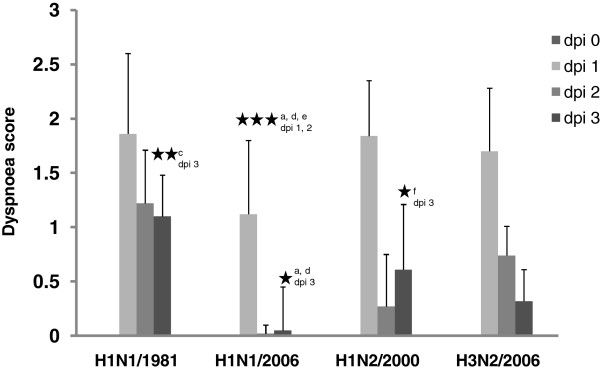
Dispnoea score. Dyspnoea (score) observed in pigs after experimental infection with influenza A viruses, dpi, days post infection; statistics: asterisk (1 p < 0.05, 2 p < 0.010, 3 p < 0.005, comparison of following groups: a H1N1/1981:H1N1/2006, b H1N1/1981:H1N2/2000, c H1N1/1981:H3N2/2006, d H1N1/2006:H1N2/2000, e H1N1/2006:H3N2/2006, f H1N2/2000:H3N2/2006).